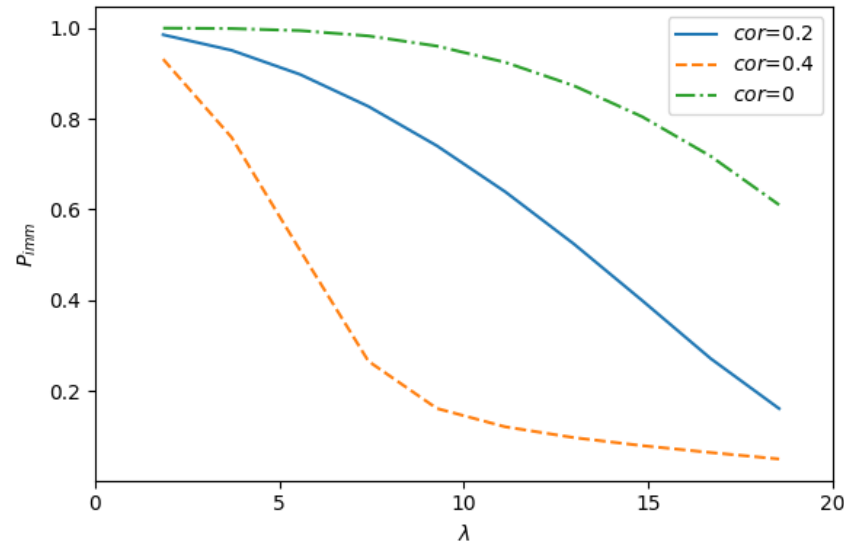
Figure 7. P imm vs. λ for BMAP s with different coefficients of